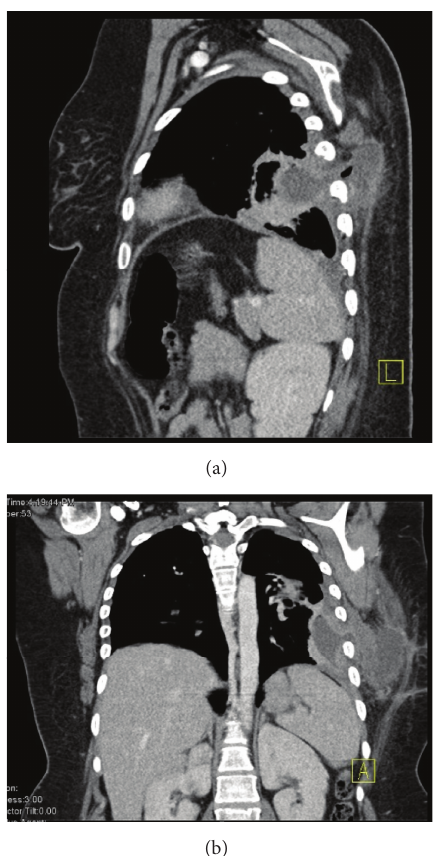
Figure 2: (a) Sagittal reconstruction of CT scan demonstrating the extension of the intrapleural collection into the subcutaneous tissue. (b) Coronal reconstruction demonstrating the same findings consistent with empyema